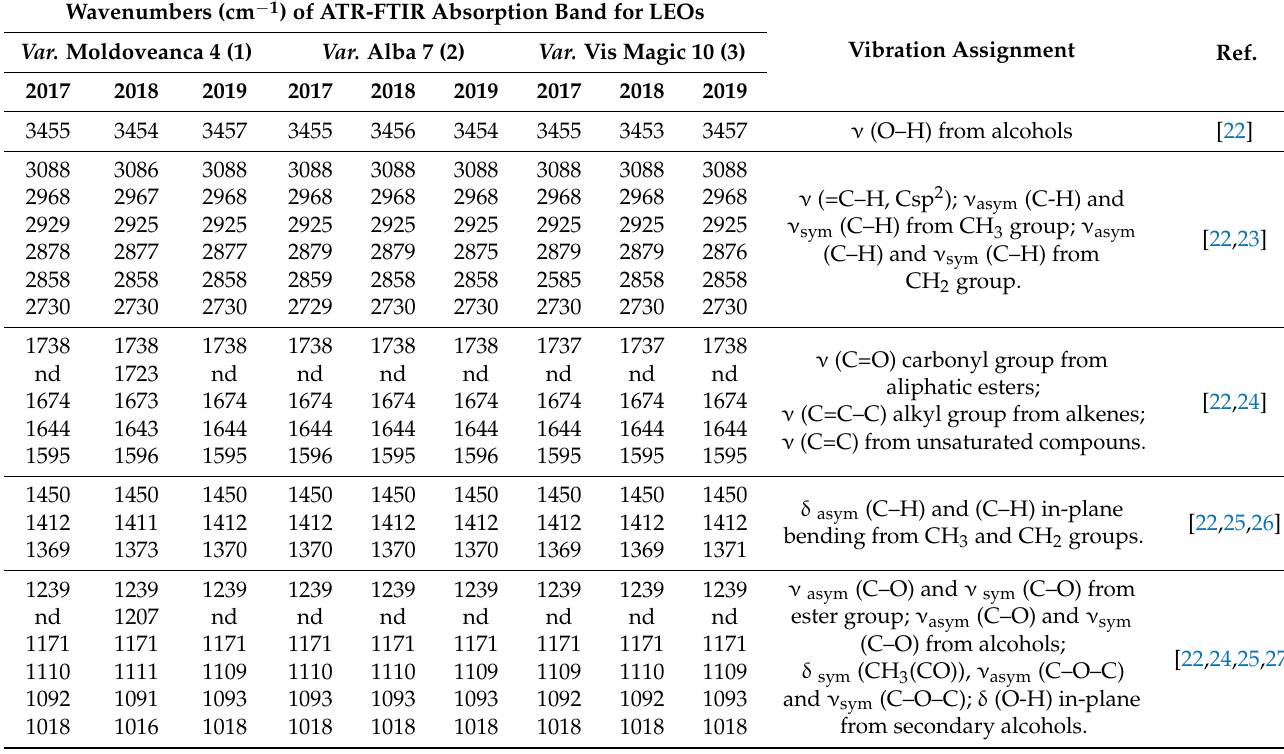
Figure 1. ATR-FTIR spectra for the essential oil samples from the investigated varieties obtained in 2017 ( a ), 2018 ( b ), and 2019 ( c ), respectively. Table 2. The ATR-FTIR absorption band for LEO samples and vibrations